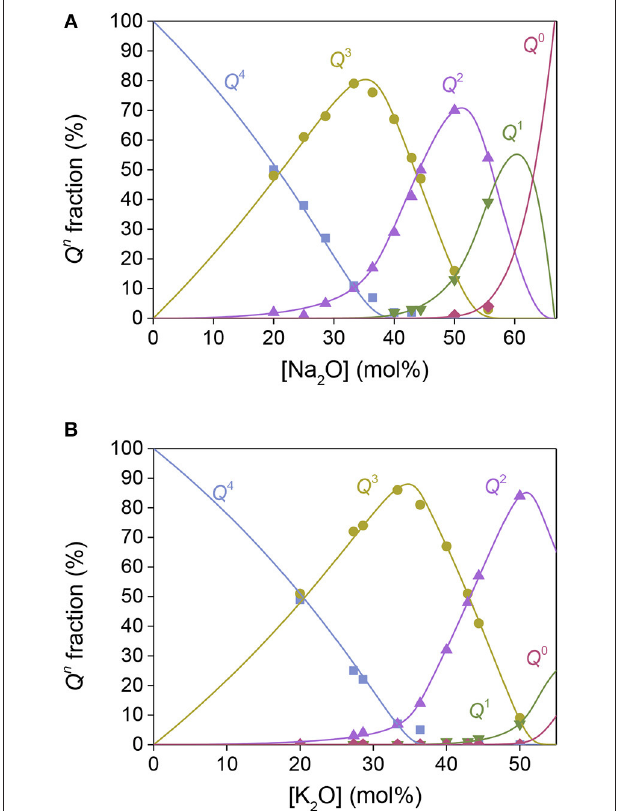
FIGURE 1 | Composition dependence of the fraction of Q n structural units in (A) sodium silicate and (B) potassium silicate glasses. The closed symbols represent 29 Si MAS NMR experimental data (from Maekawa et al., 1991 for sodium and Schroeder et al., 1973 and Maekawa et al., 1991 for potassium) and the solid lines represent the model predictions.